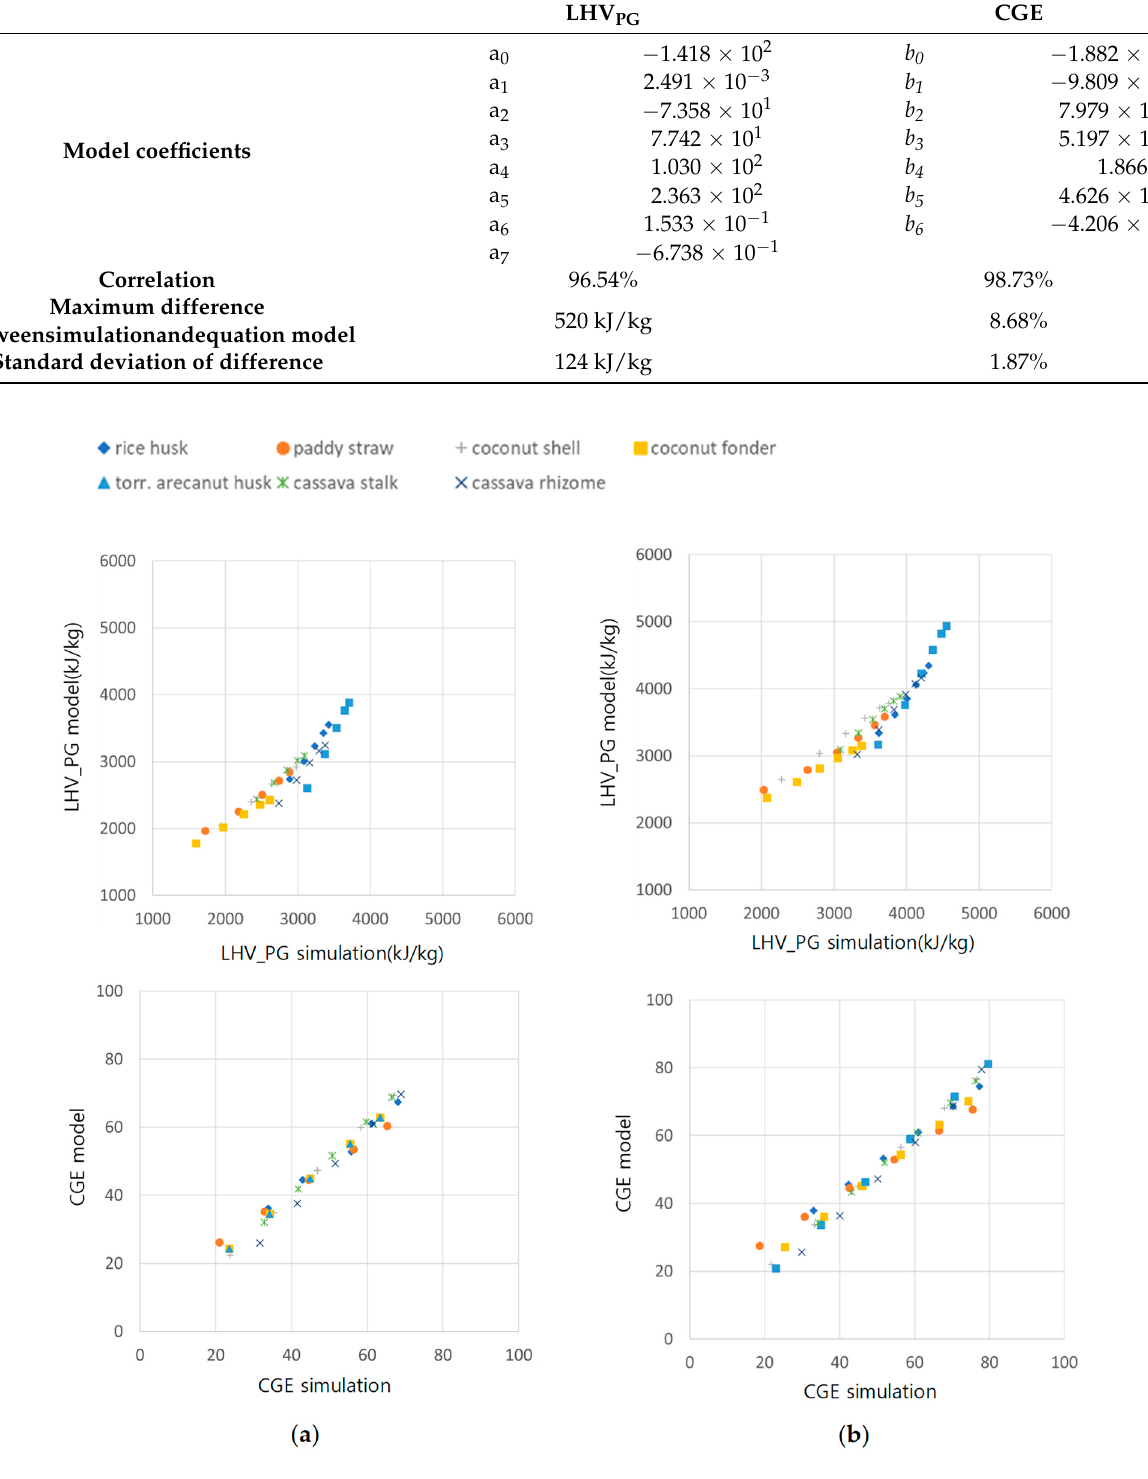
Figure 8. Scatter plot of results for LHV PG and CGE: correlation versus thermodynamic model: ( a ) two ‐ reactor model, ( b ) three ‐ reactor model.